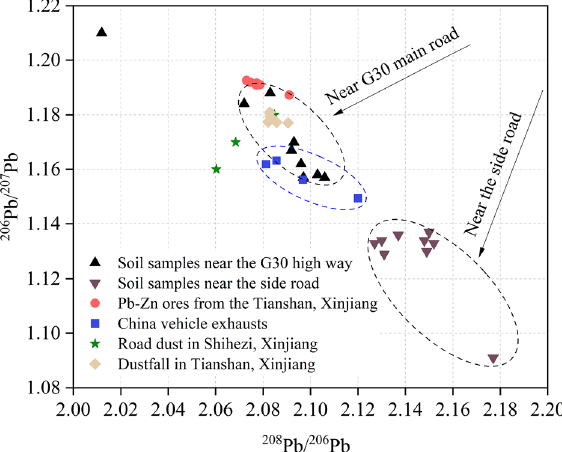
Figure 7. Comparison of Pb isotopic ratios in the topsoil with other relevant studies reported.